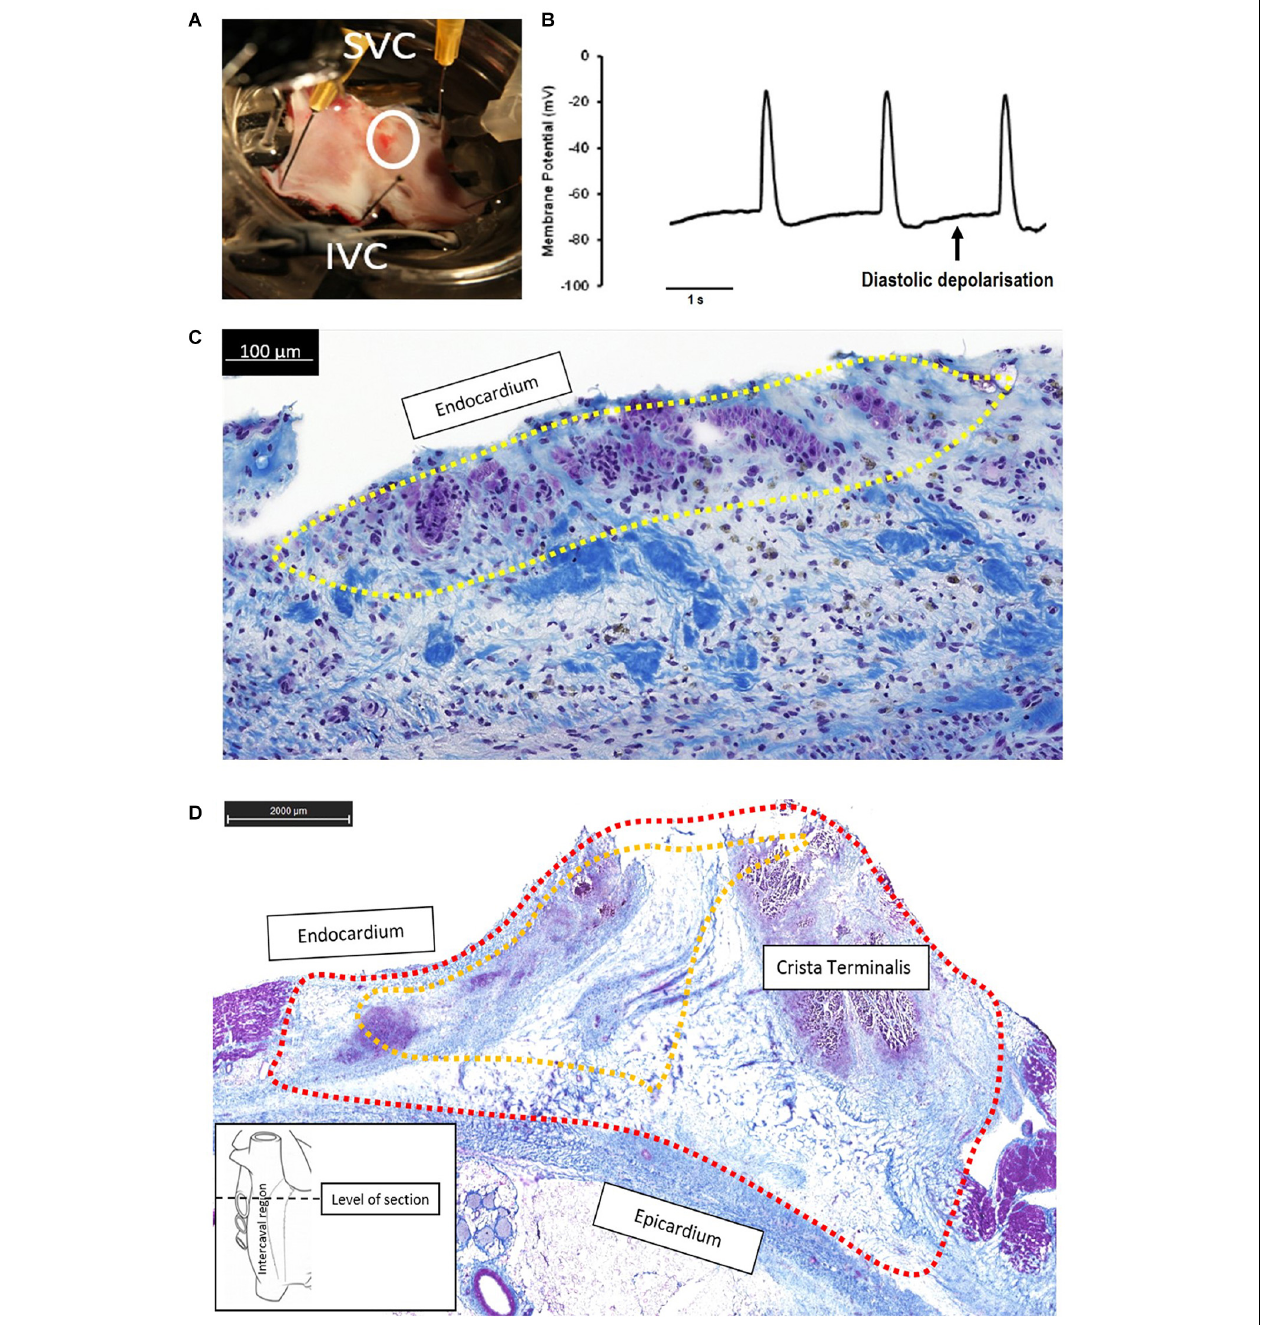
Frontiers in Physiology |